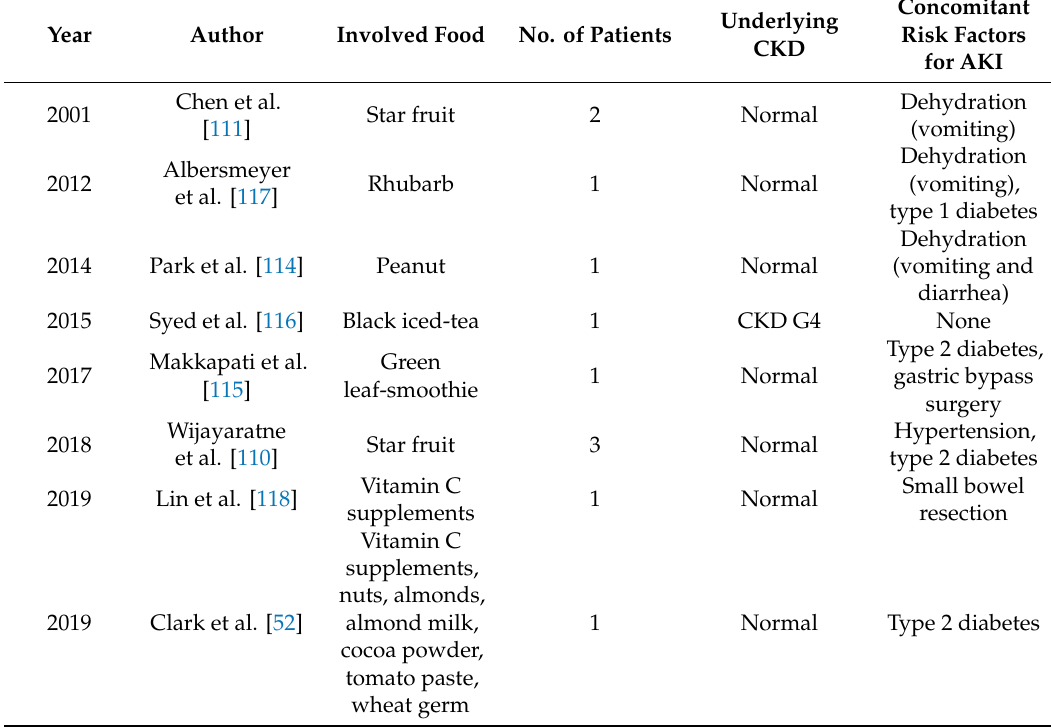
Table 2. Summary of case reports / case series of biopsy-proven oxalate nephropathy due to increased dietary oxalate